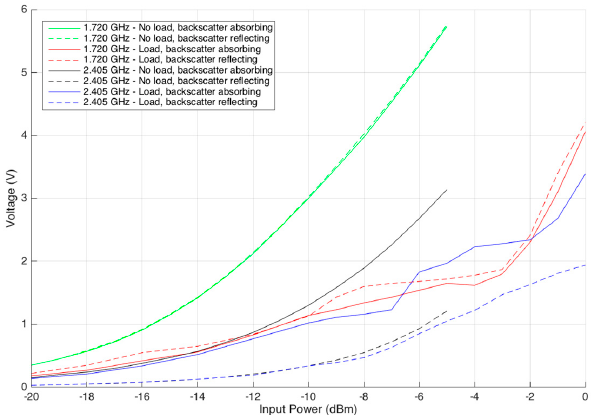
Figure 9. Input power vs. output voltage.